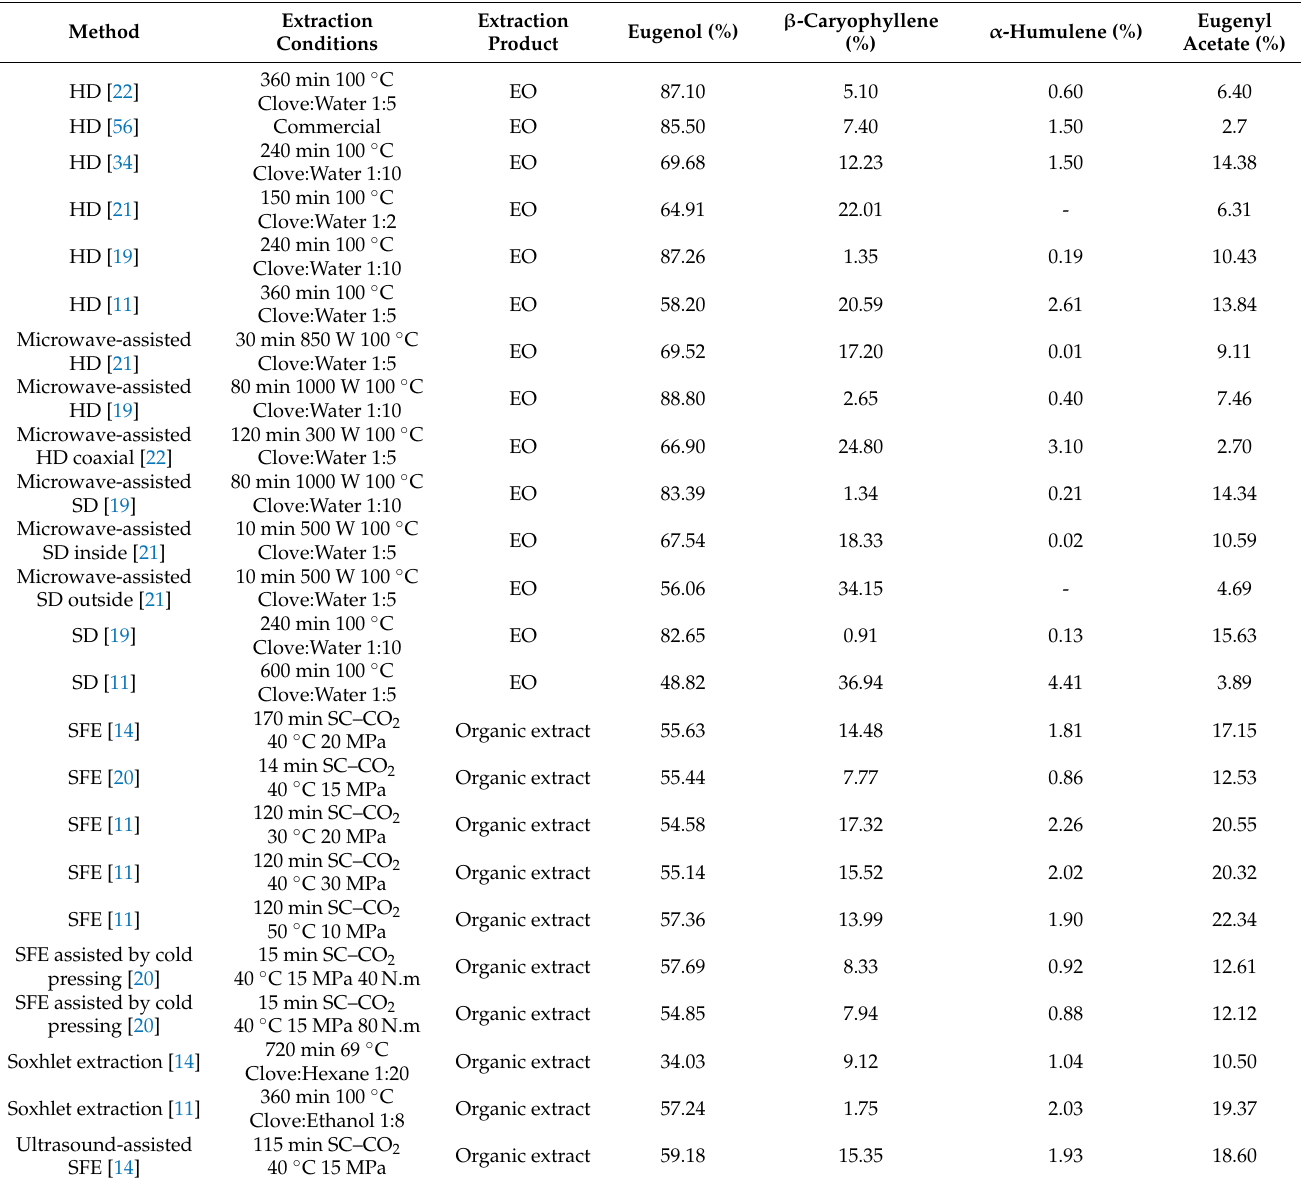
Table 2. Effect of the extraction on the concentration of the main volatile compounds of cloves